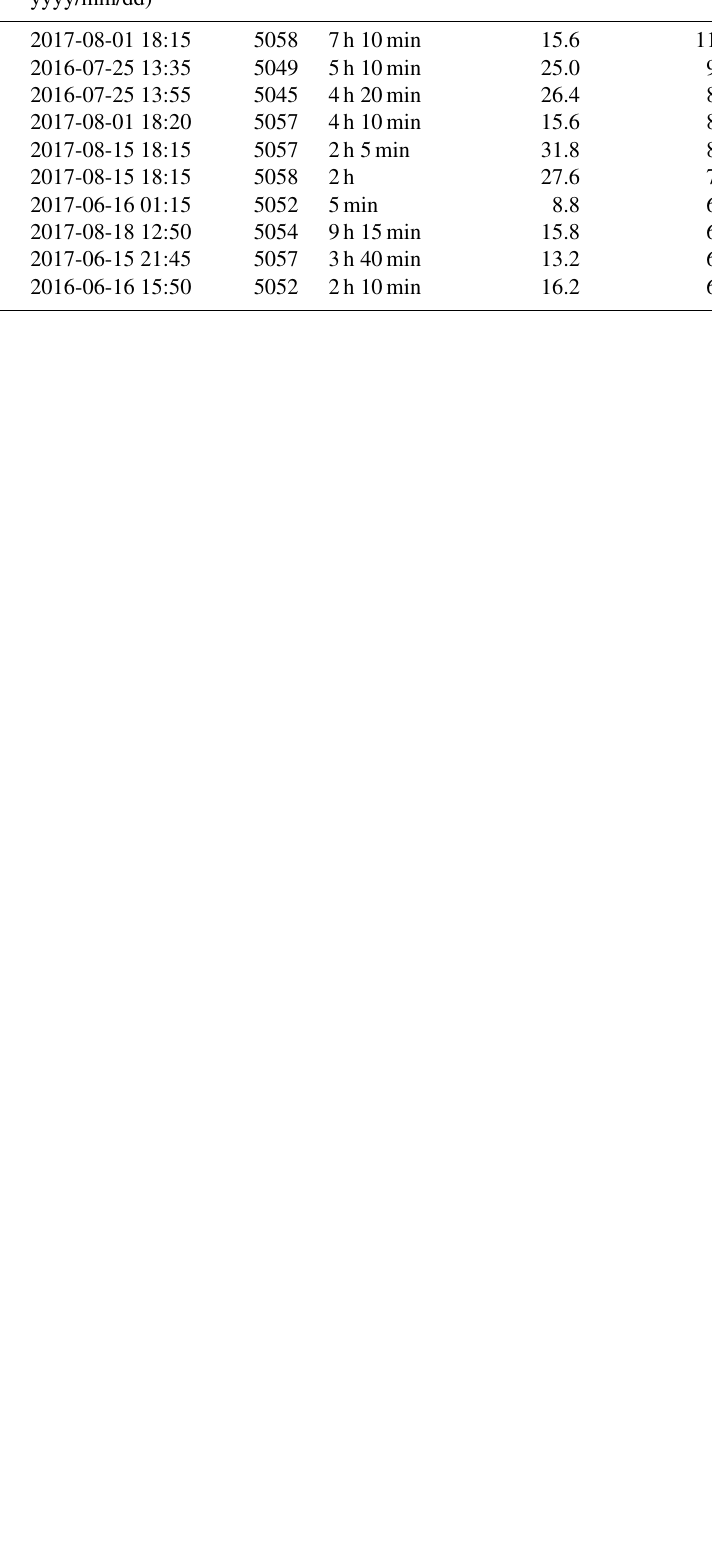
Table A5. Top 10 events for the Danish X-band product. Event Starting time